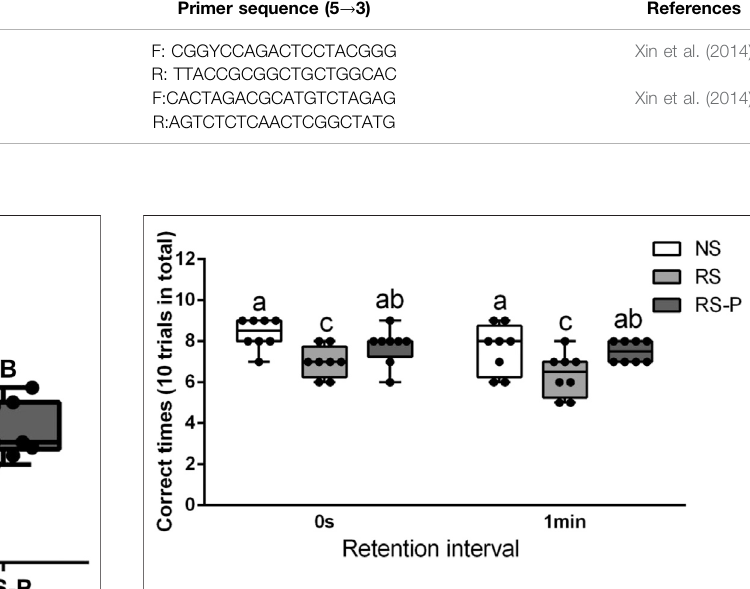
FIGURE 4 | Effects of L. johnsonii BS15 on the correct times with both 0s and 1min of retention interval by T-maze test. Data are presented with the means ± standard deviation ( n (cid:2) 8). Bars with different letters are signi fi cantly different on the basis of Duncan ’ s multiple range test ( P <